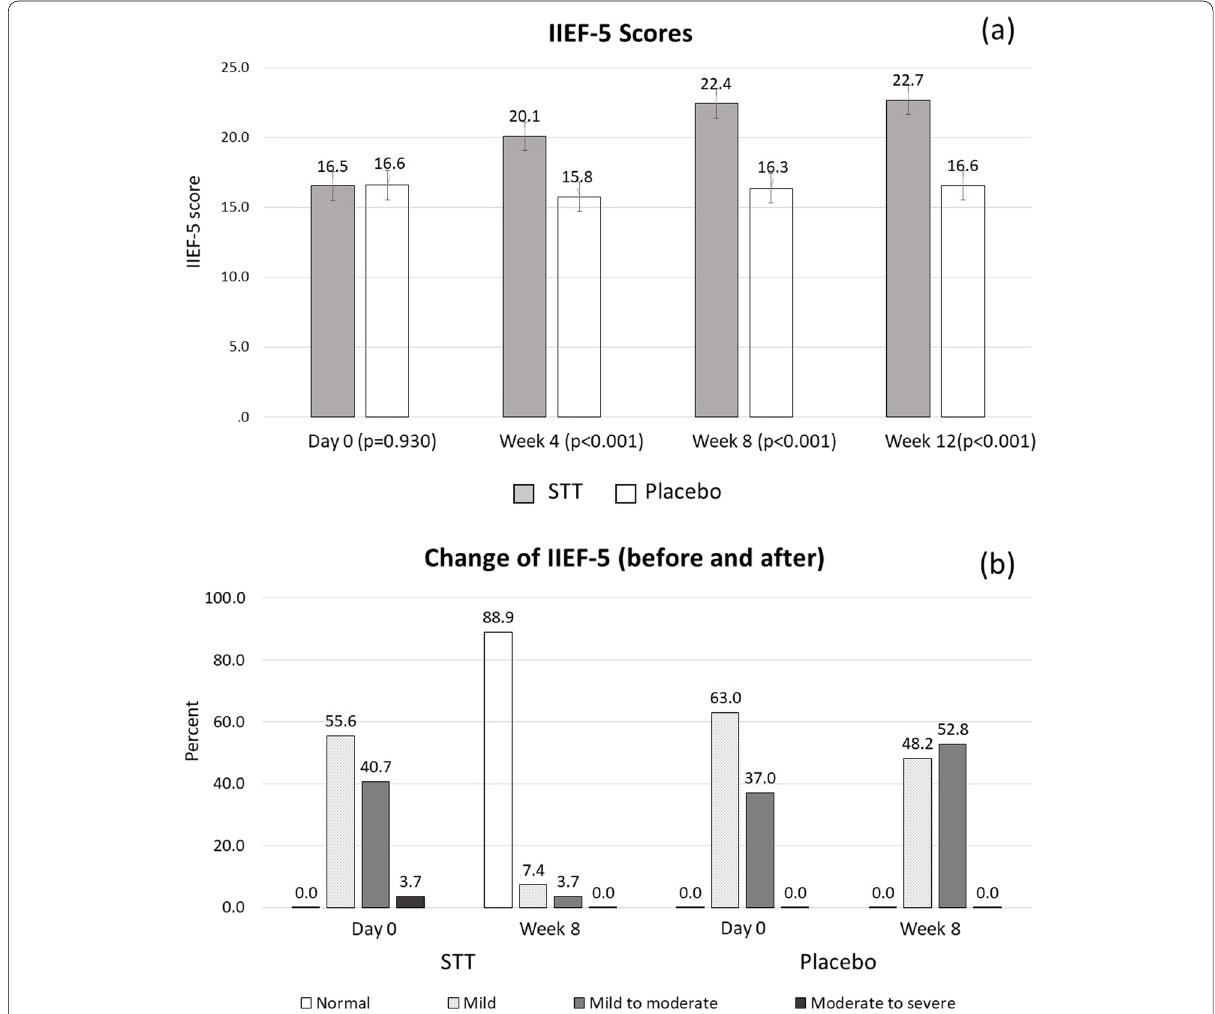
Fig. 3 International Index of Erectile Function (IIEF-5) scores in the STT and placebo groups during the treatment and follow-up study periods (12 weeks): a . IIEF-5 scores (mean SEM); b . Change in IIEF-5 scores (before and after) (percent). The percentage changes from baseline (Day 0) in IIEF ± domains ( b ) demonstrated that treatment with STT significantly improved all important domains of sexual function from the second visit (week 4) to the end of treatment (week 8). * p < 0.001 for the % change (mean SEM) from baseline (Day 0) to the end-of-treatment (week 8) and follow-up ± for 4 weeks after treatment (week 12) for STT (the gray column, N 27) compared with the placebo (the white column, N 27) = =